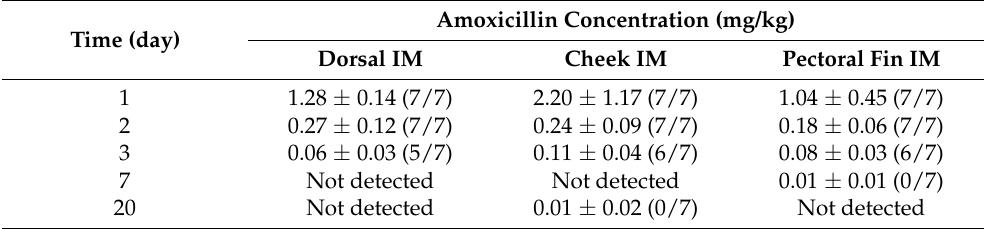
Table 3. Residue depletion of amoxicillin in muscle and skin of olive flounder ( Paralichthys olivaceus ) following intramuscular (dorsal, cheek, and pectoral fin) injection at a dosage of 40 mg/kg. Time